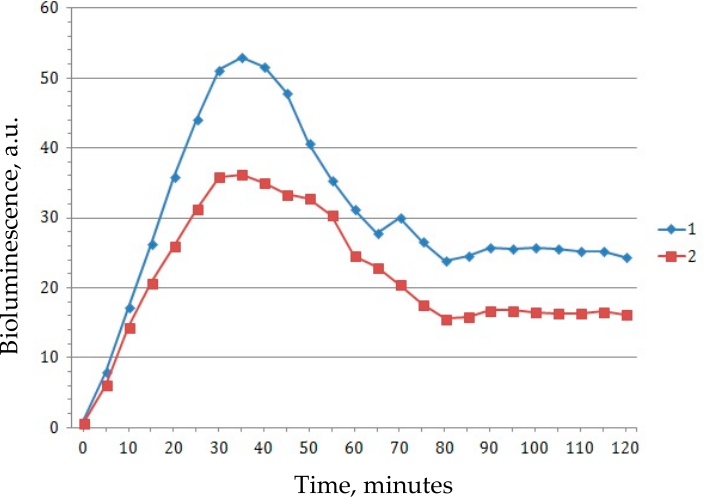
Figure 5. Protective e ff ect time dependency for C 60 in TWEEN 80 2% at concentrations 10 − 5 (1) and 10 − 4 (2) g / L.